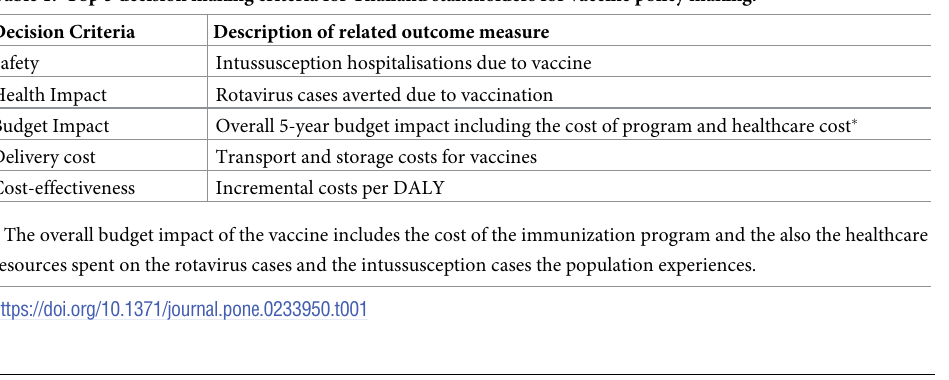
Table 1. Top 5 decision making criteria for Thailand stakeholders for vaccine policy